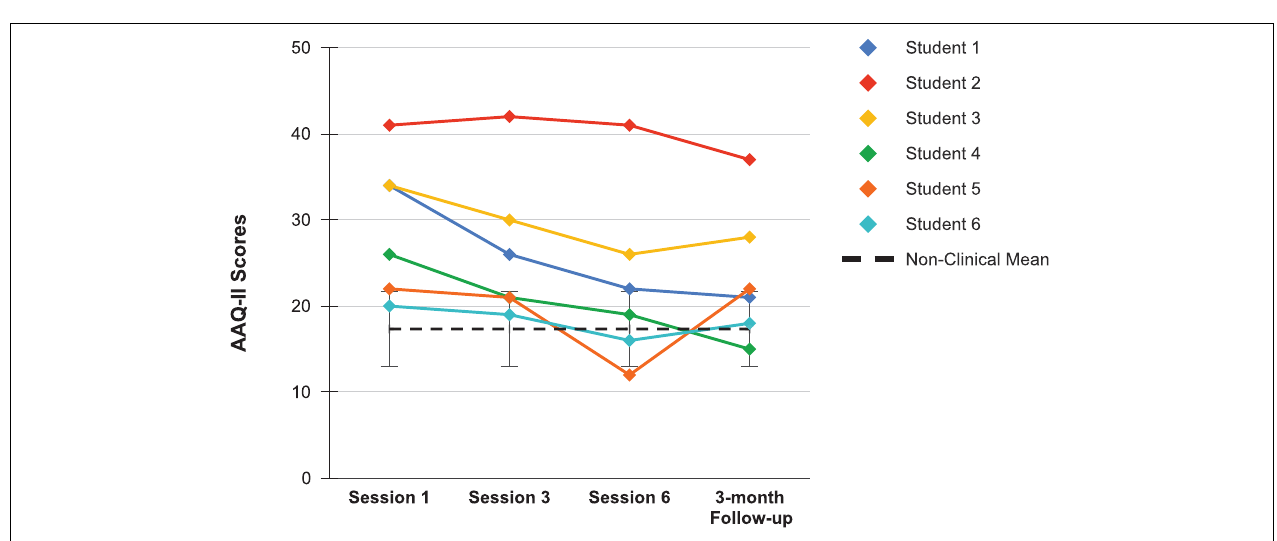
FIGURE 3 | Believability in Anxious Feelings and Thoughts scores for seven vocal students (Juncos et al., 2017) showing scores from the baseline period to post-treatment, 1- and 3-month follow-up points, also with the non-clinical mean (50.10) and bars spanning one standard deviation up/down ( SD = 16.88; Herzberg et al.,